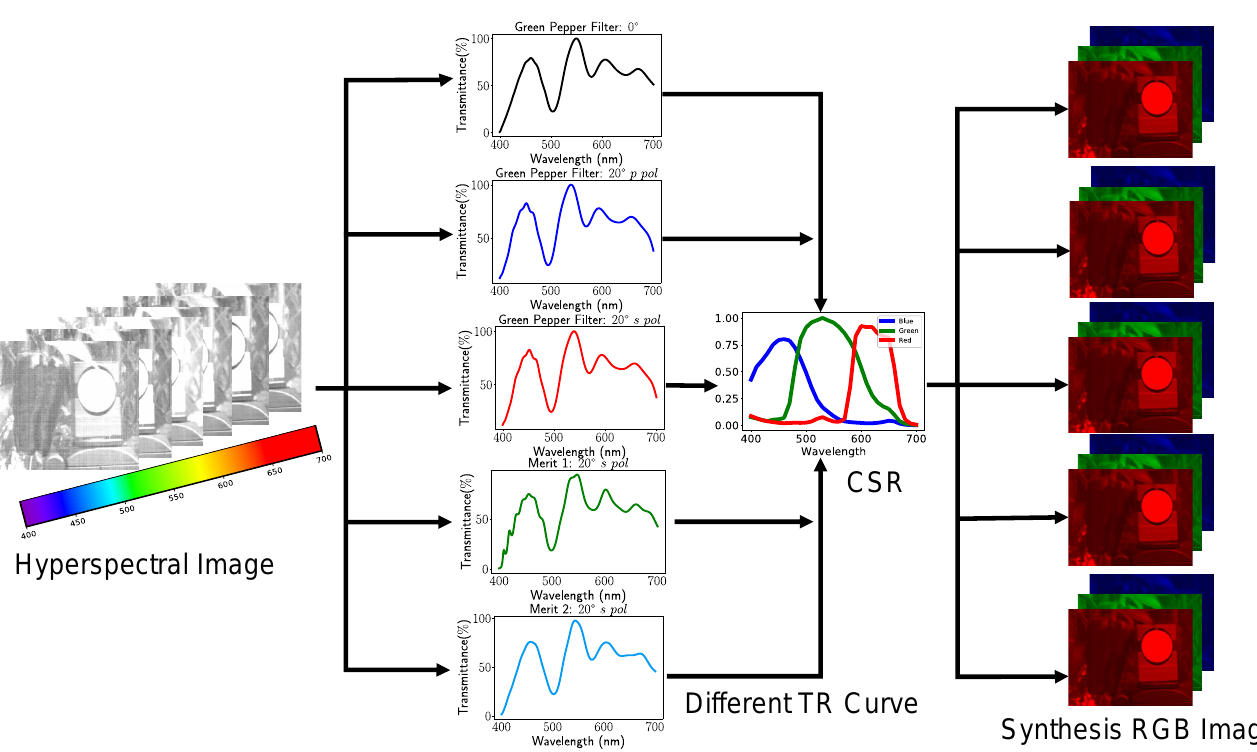
Figure 7. The above figure demonstrates the details of how to replace different transmittance curves in the optical filter layer. As a result, a different RGB feature map was generated by putting the hyperspectral image into the optical filter layer and CSR